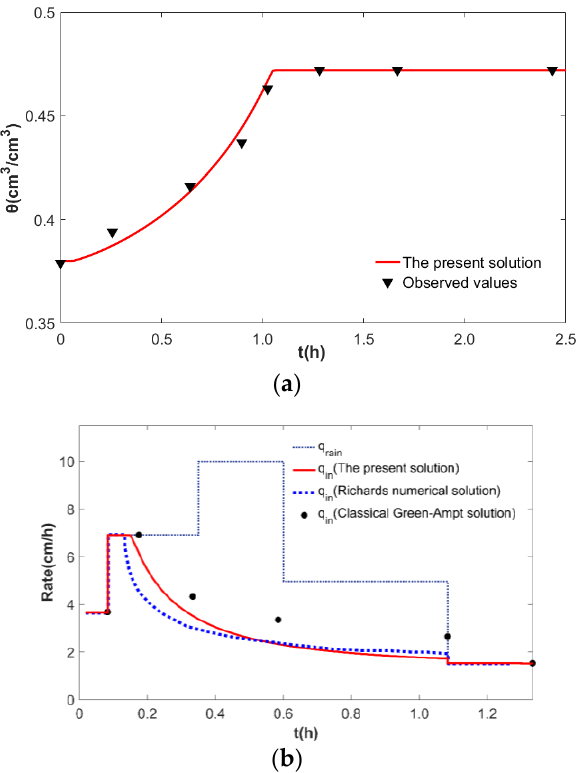
Figure 4. Comparison of surface infiltration rate between the present model and reference models. ( a ) Validation between the present solution and observed data under steady rainfall intensity; ( b ) Validations between the present solution and other solutions under unsteady rainfall intensity.